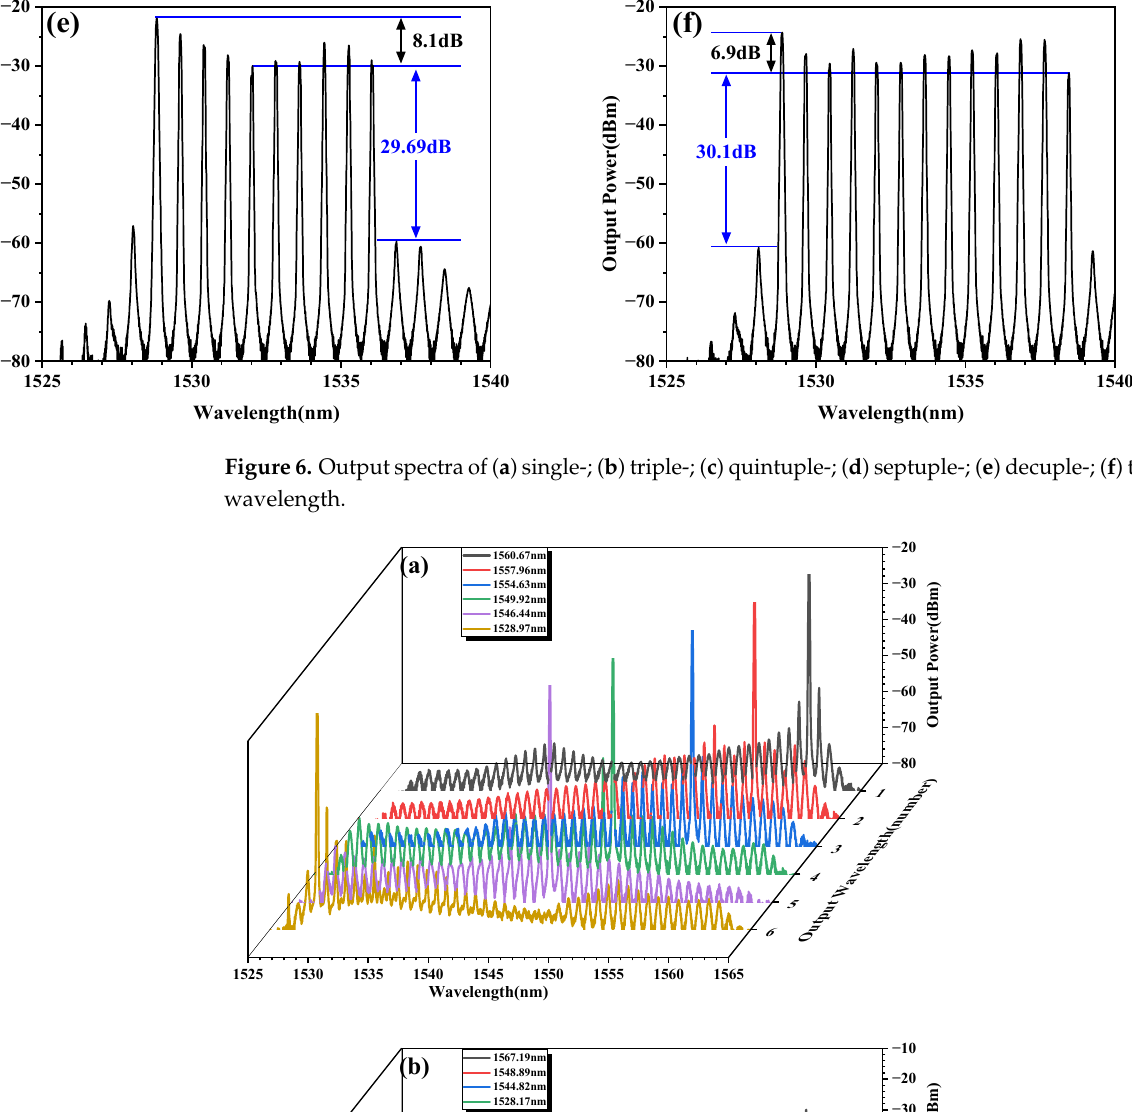
Figure 6. Output spectra of ( a ) single-; ( b ) triple-; ( c ) quintuple-; ( d ) septuple-; ( e ) decuple-; ( f ) thir- teen-wavelength.